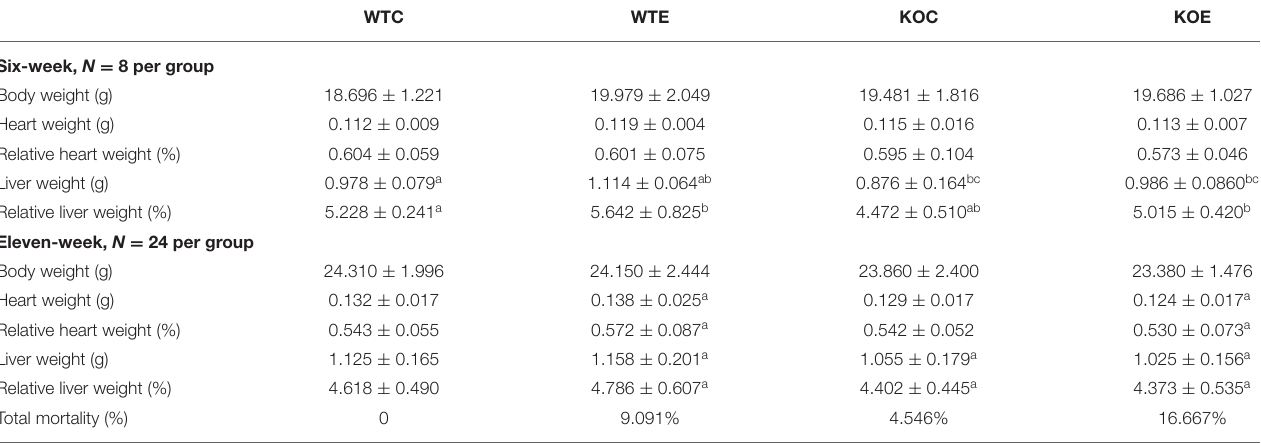
TABLE 1 | General parameters of the animals at 6 or 11